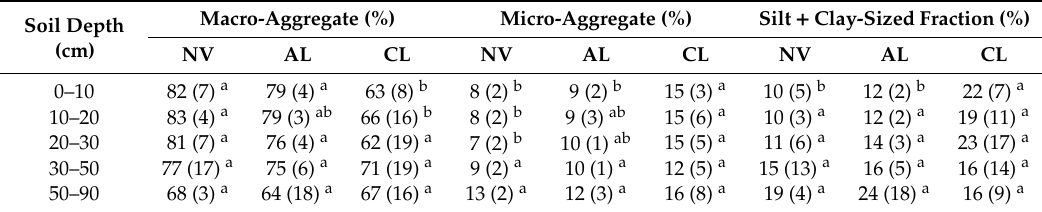
Note: Expressing as mean (standard deviation). Lowercase letters indicate significant di ff erences among the di ff erent stages after agricultural abandonment at p < 0.05 level on the basis of the least significant di ff erence (LSD) test. NV, native vegetation land; AL, abandoned cropland; CL,